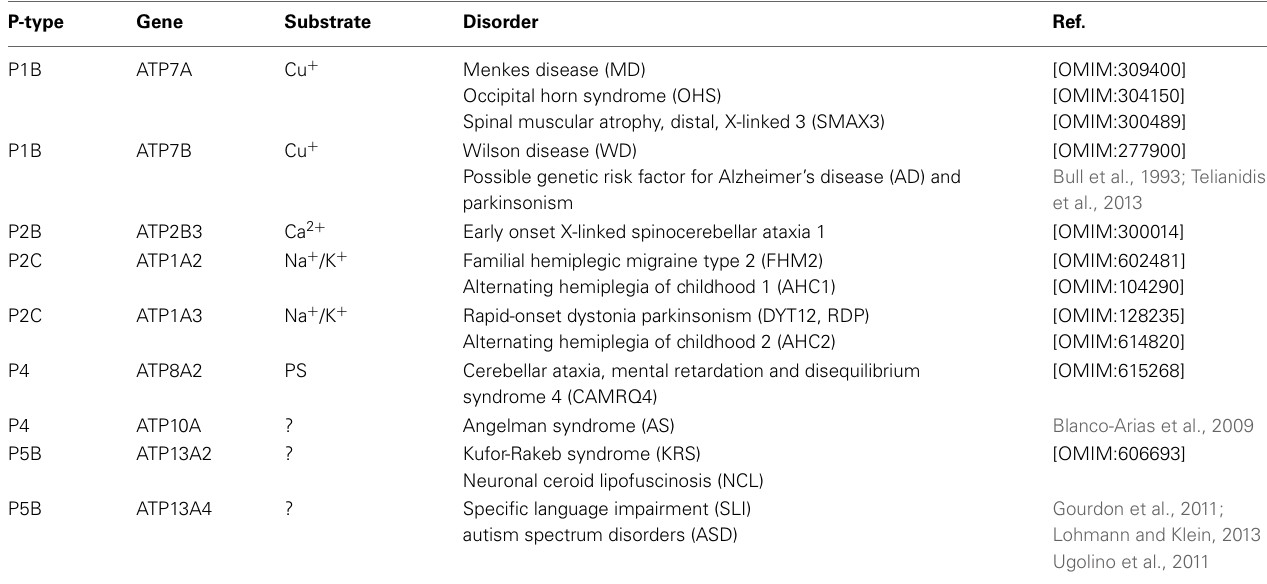
Table 1 | P-type ATPases involved in neuronal disorders.